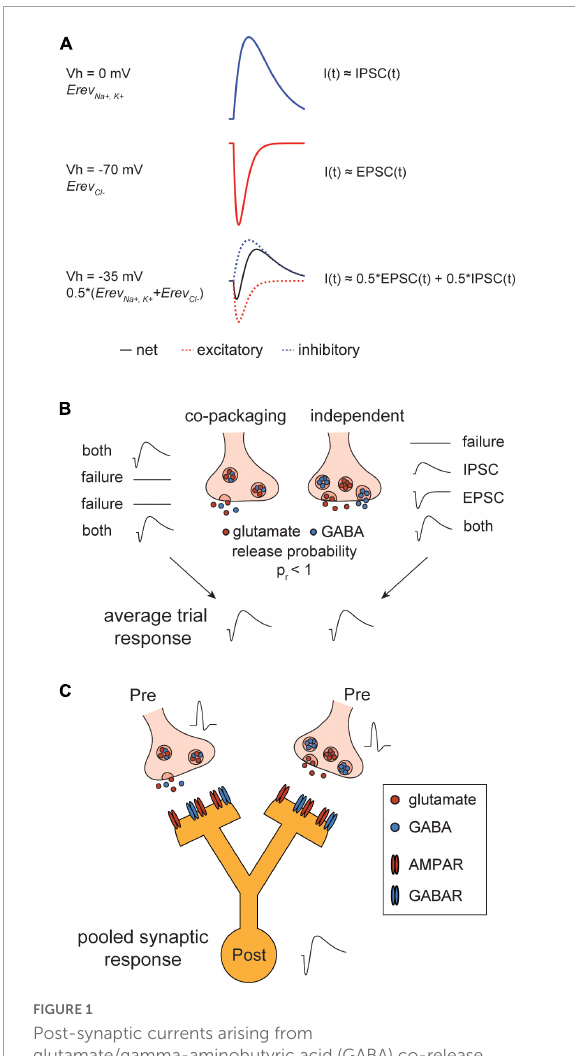
FIGURE1 Post-synaptic currents arising from glutamate/gamma-aminobutyric acid (GABA) co-release. (A) Composite signal of glutamate/GABA co-release is biphasic. Top, simulated post-synaptic current (PSC) at reversal potential of AMPA-type glutamate receptor (AMPAR) (Vh = 0 mV). At this membrane potential, net current is inhibitory PSC (IPSC) dominant. Middle, simulated PSC at reversal potential of GABAR (V h = –70 mV). At this membrane potential, net current is excitatory PSC (EPSC) dominant. Bottom, simulated PSC at intermediate potential of the two receptors (V h = –35 mV). The net current is biphasic with reduced amplitudes of inward and outward currents. (B) Stochastic vesicle release causes PSC distributions to diverge between “co-packaging”